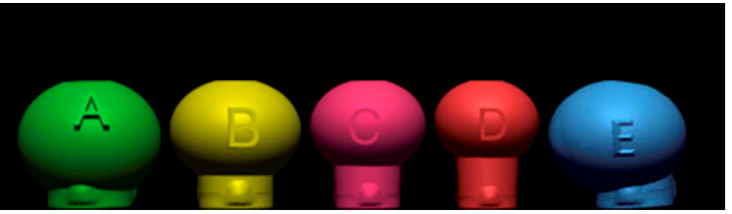
Figure 1. Computer-aided design (CAD) of computer-aided manufacturing (CAM) MZRs used as samples. Table 1. Main characteristics of MZRs used in samples.